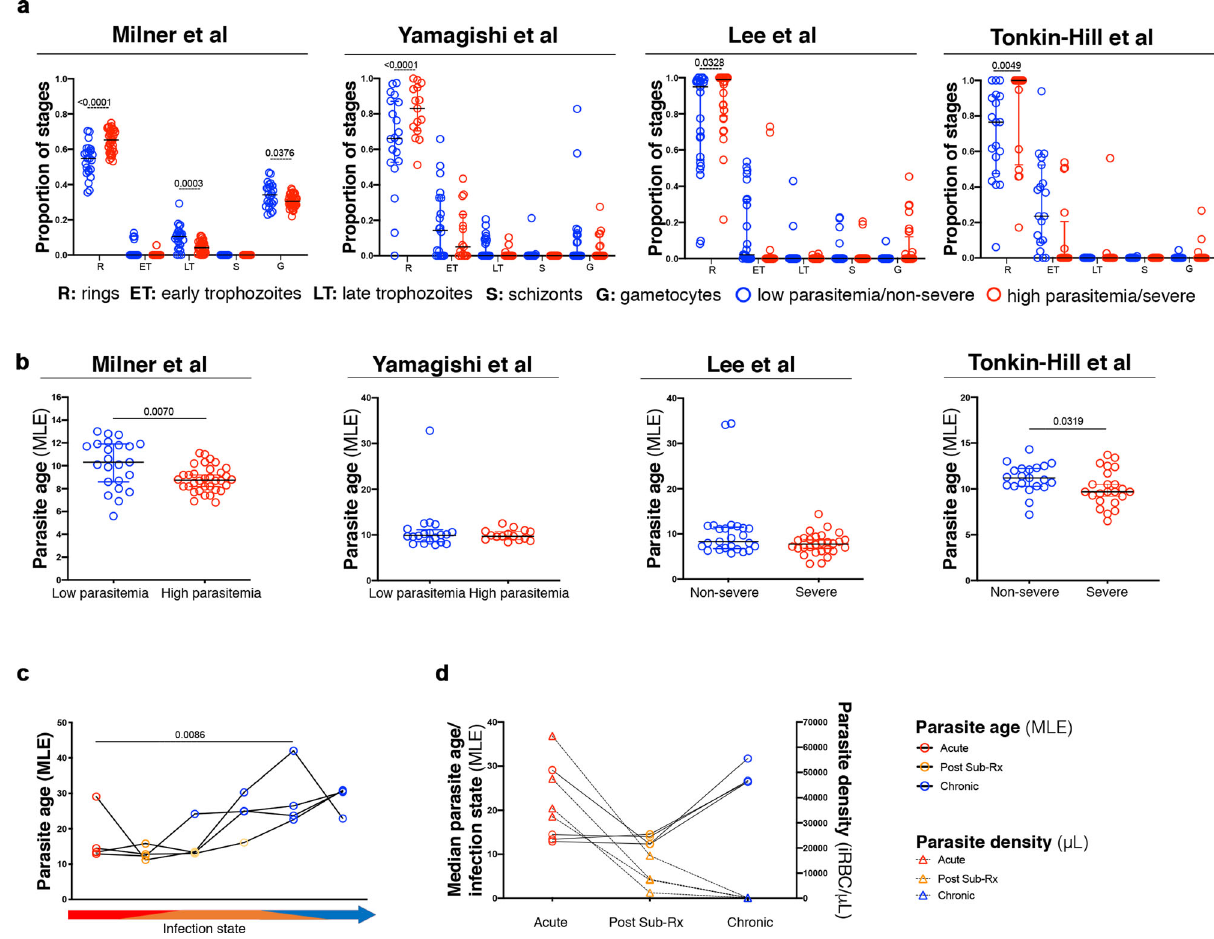
Fig. 4 Whole transcriptome analyses across different studies supports increased circulation time in lower vs higher parasitaemias. a Predicted proportion of ring, early trophozoite, late trophozoite, schizont, and gametocyte stages according to Tonkin-Hill et al. ’ s mixture model 17 using whole transcriptome data from low parasitemia samples in Milner et al. ( n = 58). and Yamagishi et al. ( n = 36), and non-severe samples in Lee et al. ( n = 46) and Tonkin-Hill et al. ( n = 44) (blue) and higher parasitaemias or severe malaria cases of the same studies (red). One-way ANOVA with Sidak multiple comparisons test. b Maximum likelihood estimation (MLE) of the hours post invasion of parasites in low parasitemia samples in Milner et al. ( n = 58) and Yamagishi et al. ( n = 46) and non-severe samples in Lee et al. ( n = 46) Tonkin-Hill et al. ( n = 44) (blue) and higher parasitaemias or severe malaria cases of the same studies (red). Data indicate mean ± SD; two-tailed Mann – Whitney test. c Maximum likelihood estimation (MLE) according to Lemieux et al. 16 of the hours post invasion of longitudinal P. coatneyi parasites during acute (red), post sub-curative treatment (orange), and chronic (blue) infection of four monkey samples in Cordy et al. RM one-way ANOVA (with Greenhouse – Geisser correction). d P. coatneyi parasite densities (triangles) and average parasite age by MLE (circles) during acute (red), post sub-curative treatment (orange), and chronic (blue) infection of four macaque samples in Cordy et